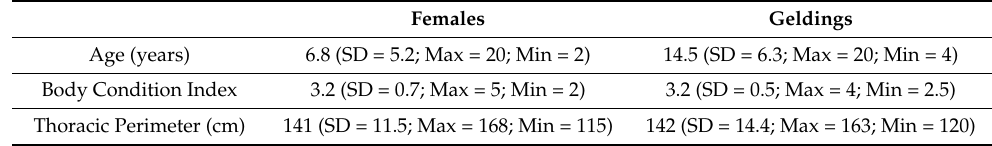
Table 2. Descriptive characteristics of the studied population a.